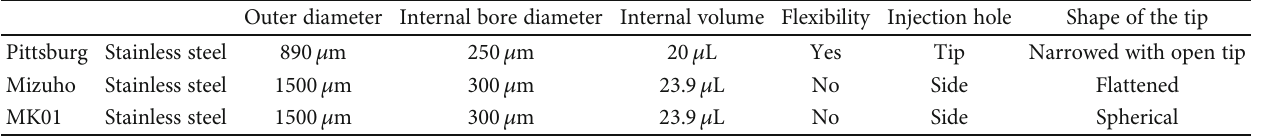
Table 1: Basic characteristics of the